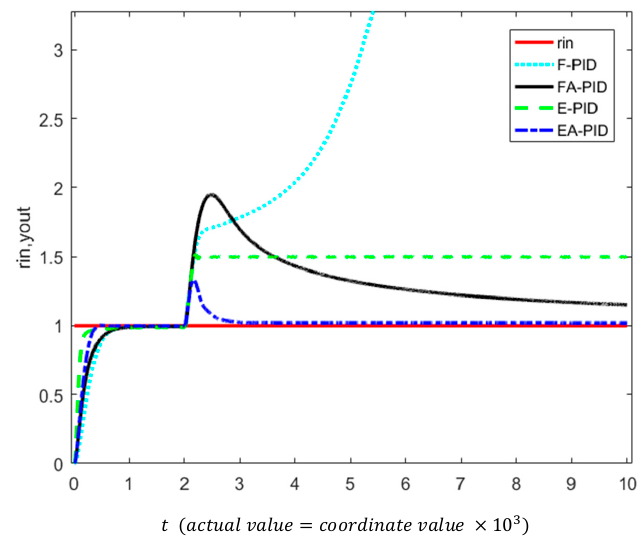
Figure 7. Simulation results of saturation tests of four AI-CC systems.